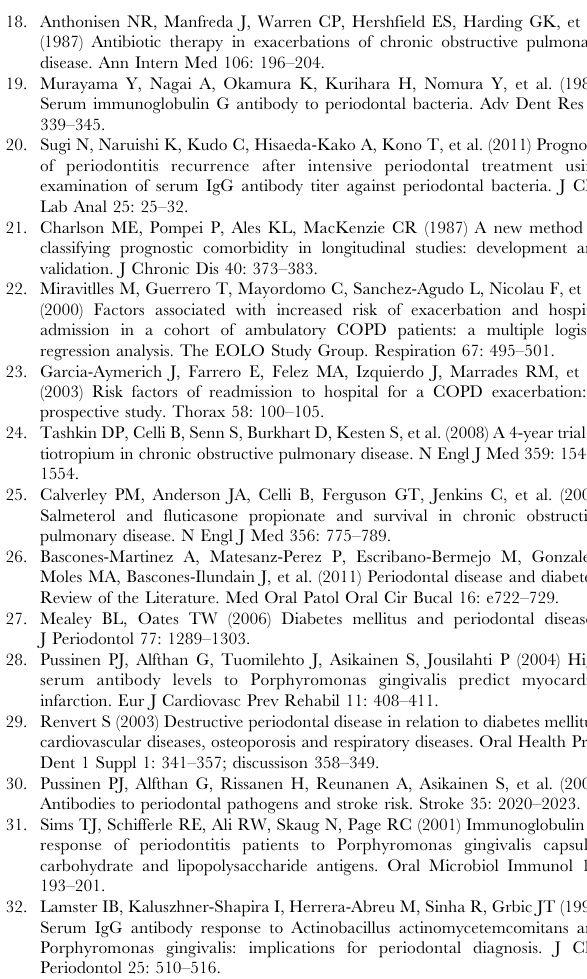
Table S3 Frequency of exacerbations and elevated serum IgG antibody titer against Porphyromonas gingivalis in dentate patients group. Table S4 Frequency of exacerbations and elevated serum IgG antibody titer against Porphyromonas gingivalis in patients with normal and abnormal swallowing reflexes: subanalysis of 56 patients. Table S5 Comparison of inflammatory markers in sputum from patients with normal and higher IgG titer against Porphyromonas gingivalis : subanalysis of 46